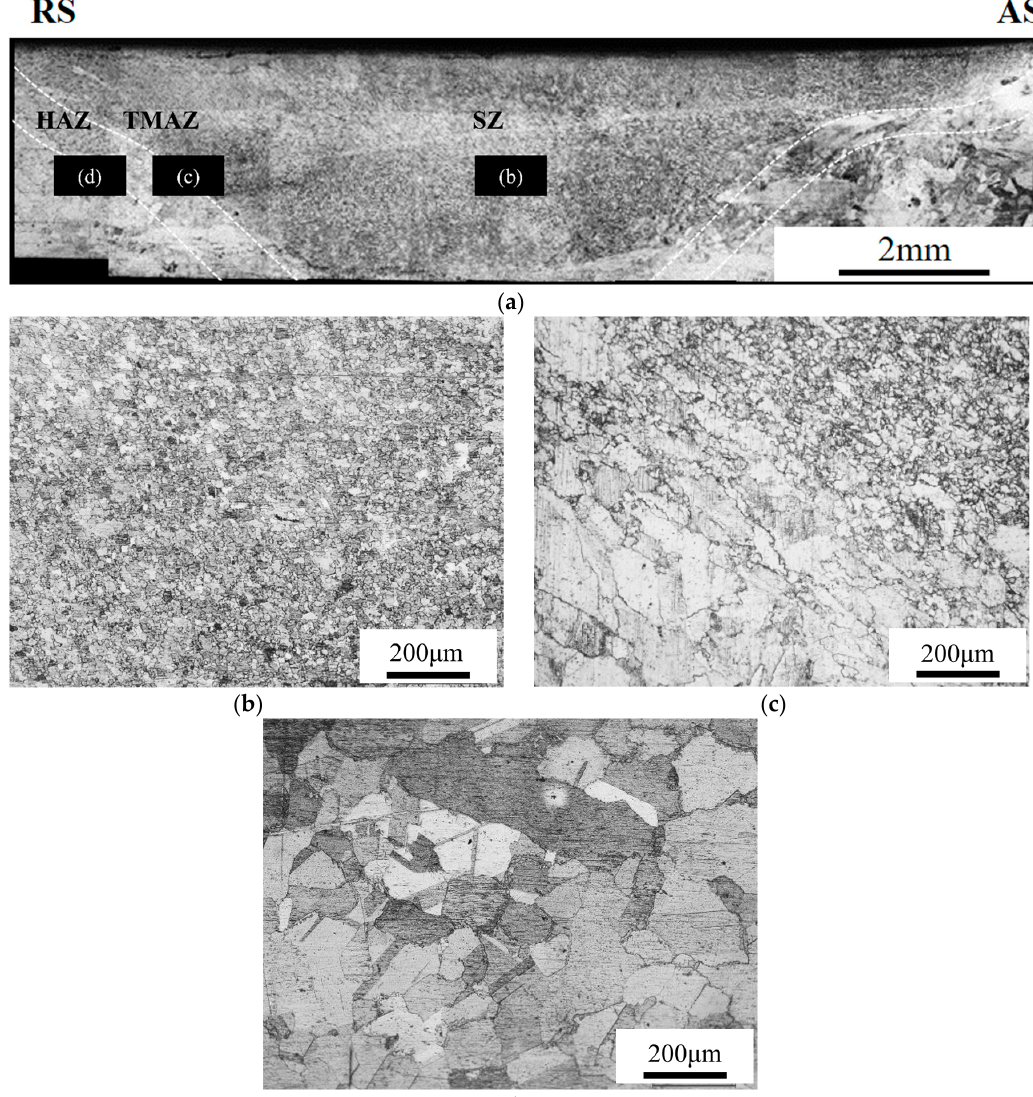
Figure 6. Cross-sectional macrograph of ( a ) the FSW region and ( b ) micrographs of the stir zone (SZ), ( c ) thermo-mechanical-a ff ected zone (TMAZ) and ( d ) heat-a ff ected zone